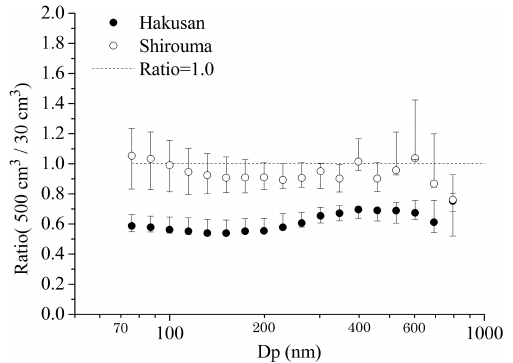
Figure 7. Size distribution of the ratio of the BC mass concentration in the snow sample melted in the 500cm 3 bottle to that melted in the 30cm 3